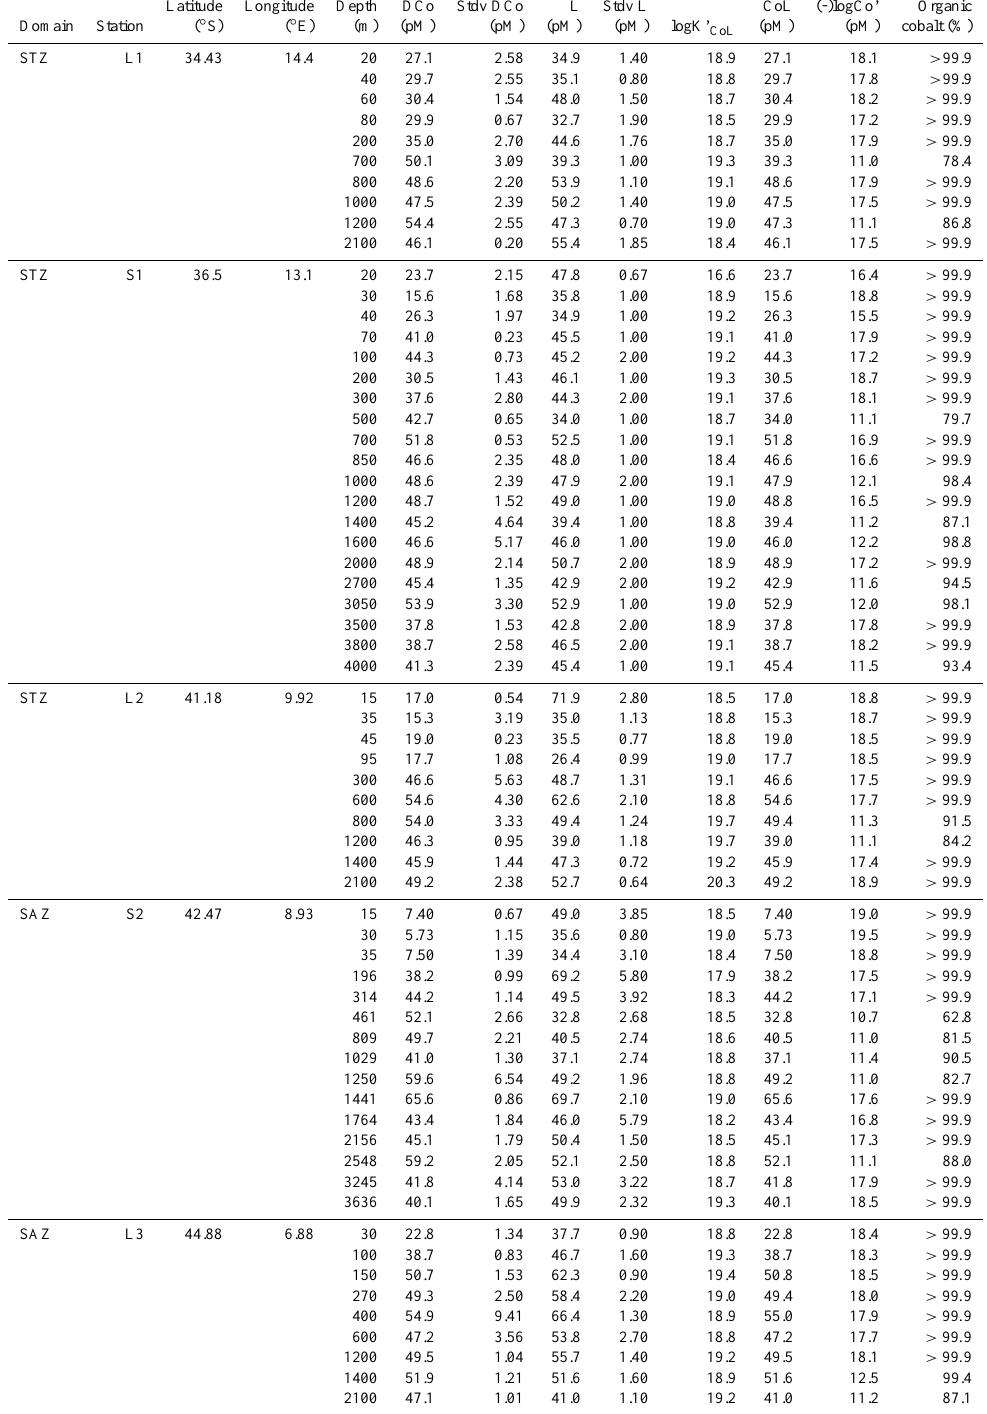
Table 1. All data of the organic speciation of dissolved cobalt obtained in the southeastern Atlantic and the Southern Ocean during the MD166 BONUS-GoodHope cruise in 2008: dissolved cobalt concentrations ([DCo]; Bown et al., 2011), the organic cobalt-binding ligand concentrations ([L]), the conditional stability constant of CoL complexes (K’ CoL ), organic (CoL) and inorganic (Co’) cobalt concentrations, and the percentage of organically bound dissolved